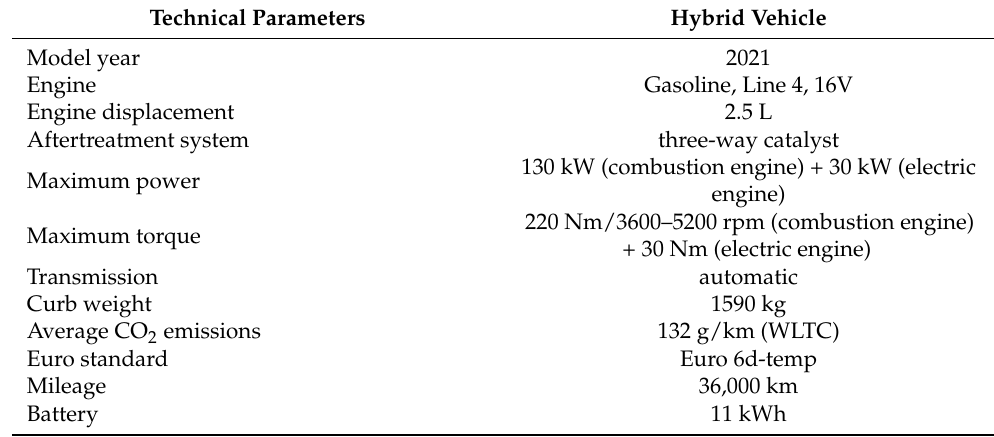
Table 3. Technical parameters of the tested